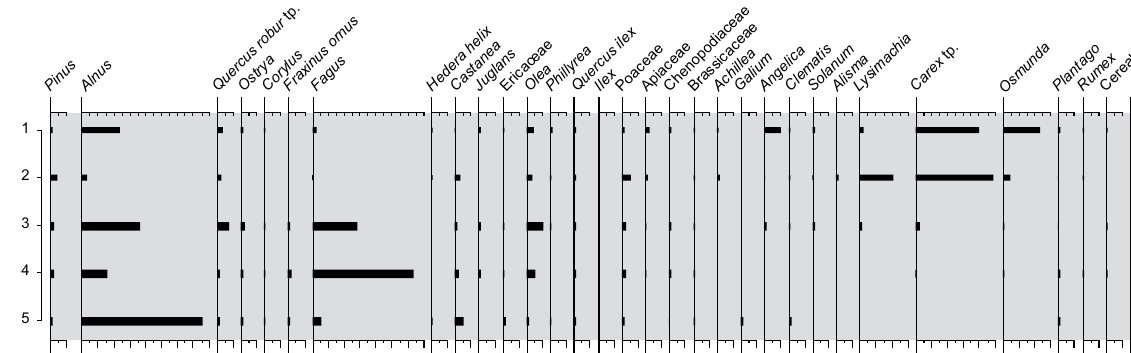
Fig. 6. Pollen diagram of five surface samples (see location map, Fig.